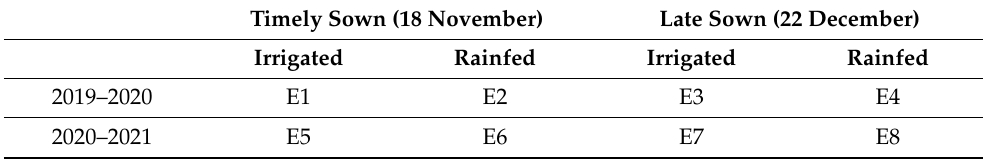
Table 1. Codes used for production environments during 2019–2020 and 2020–2021.